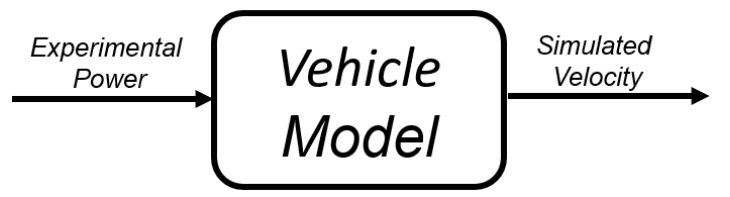
Figure 14. Vehicle model input/output scheme.